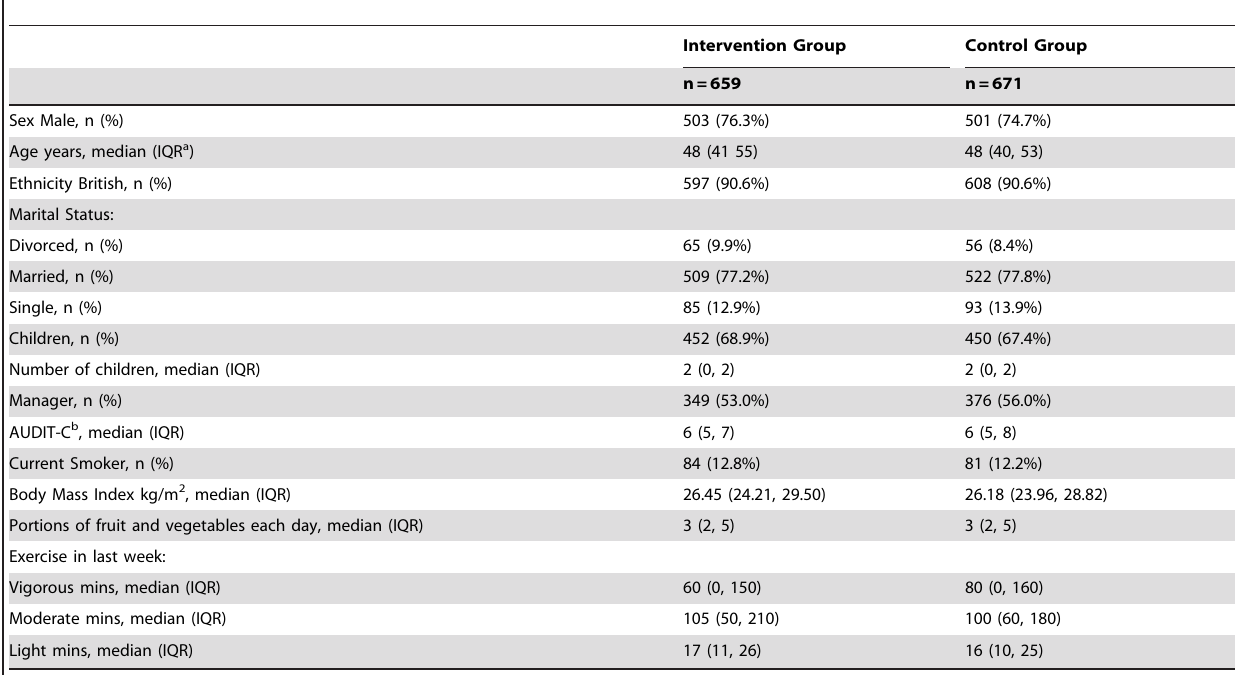
Table 1. Demographics and health behaviours at